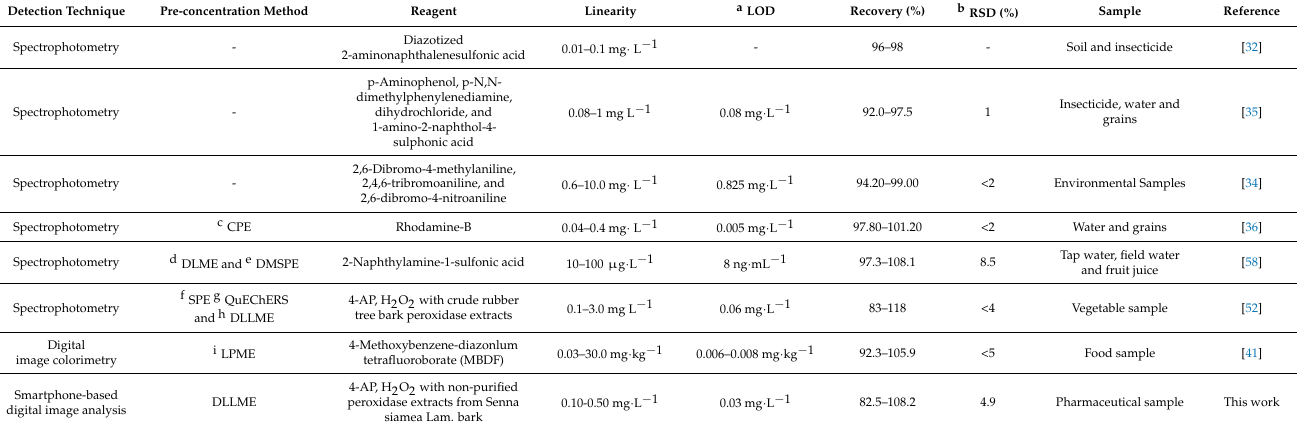
Table 1. Comparison of peroxidase enzymatic reaction-DLLME and smartphone-based digital image method with other spectrophotometric and digital image colorimetric methods for the determination of carbaryl in various samples.